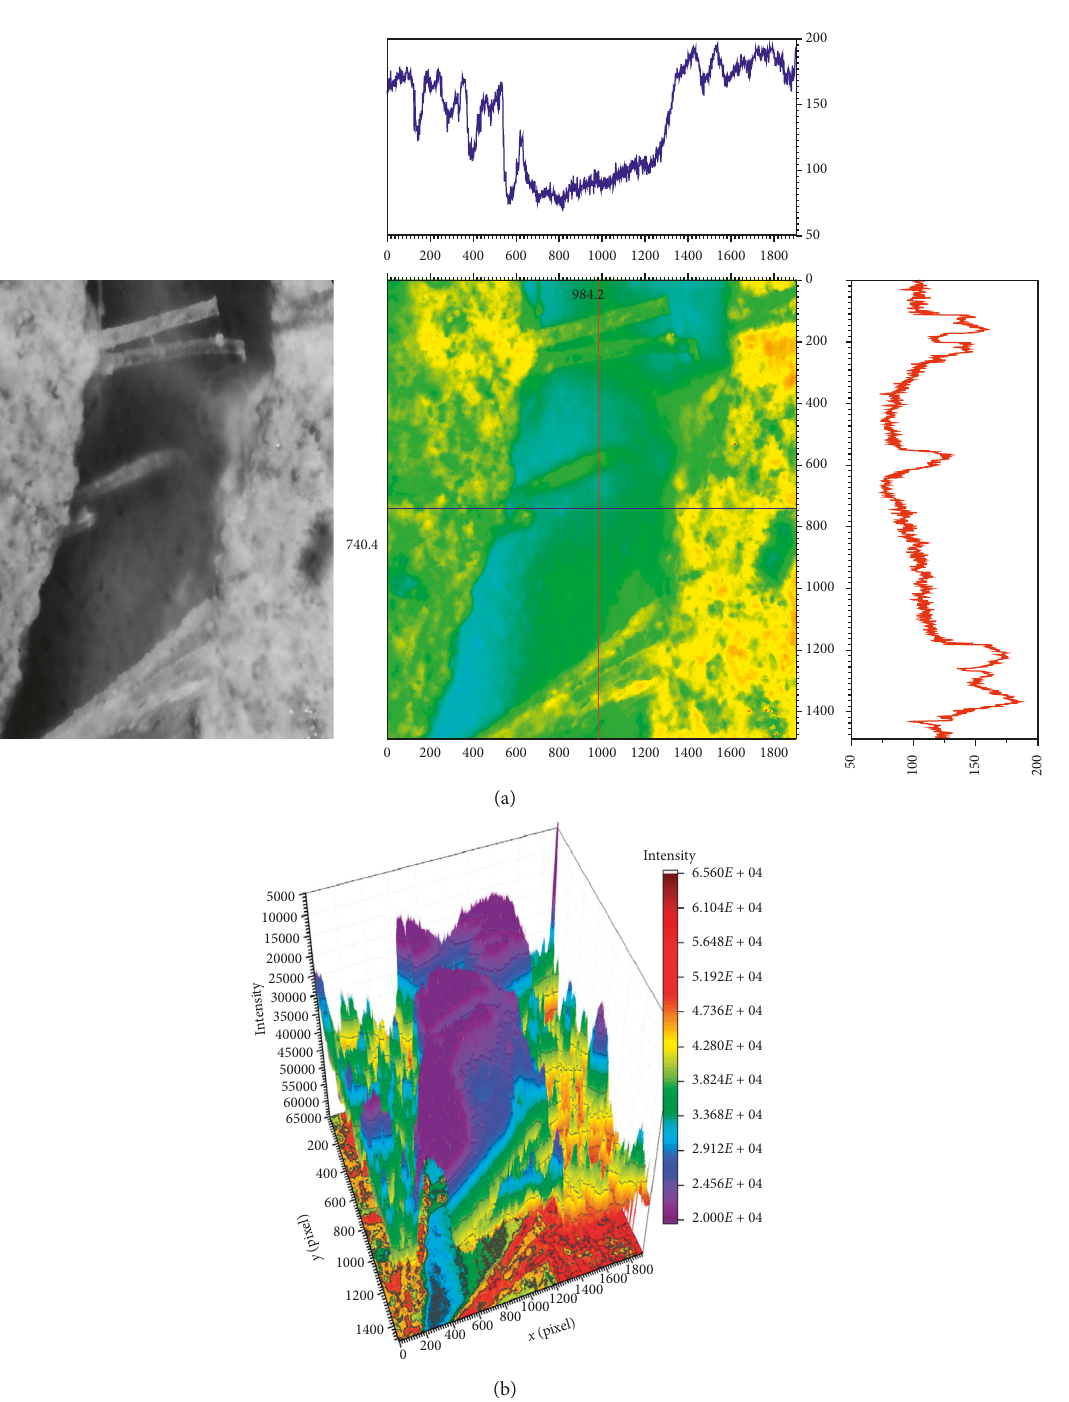
Figure 10: Gray scale image of a crack with torn filamentous concrete fillers, profiles of reflected light intensity, and 3D graph of crack with the axis of the intensity